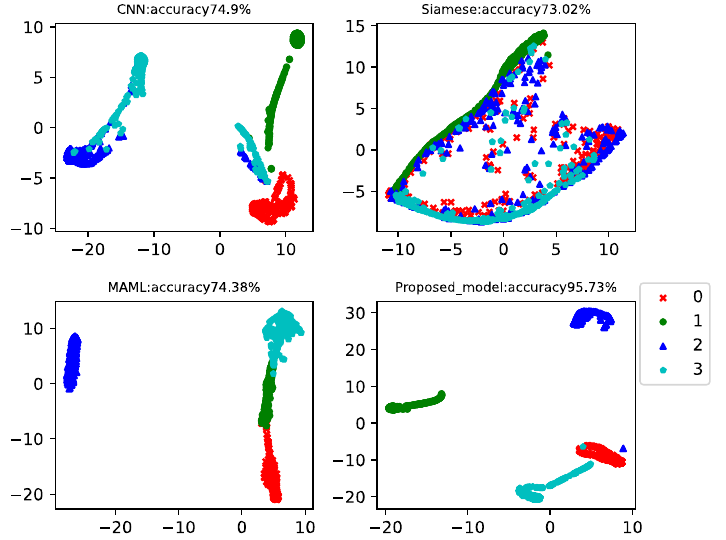
Figure 8. Four-way-one-shot diagnosis of the generator bearing data for the wind turbines using different algorithms.